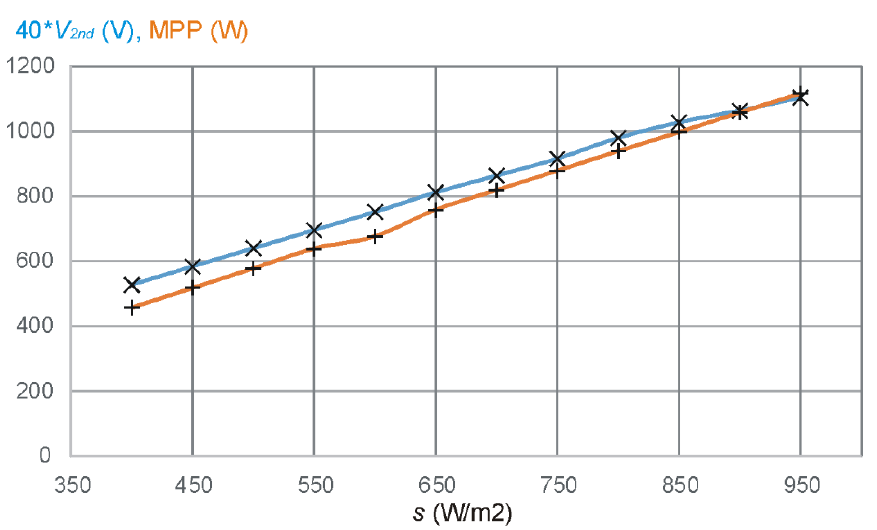
Figure 10. Maximum power point MPP in W and scaled second harmonic amplitudes of the voltage ripples 40* V 2 nd in V for the proposed MPPT method versus solar irradiance s in W/m 2 .